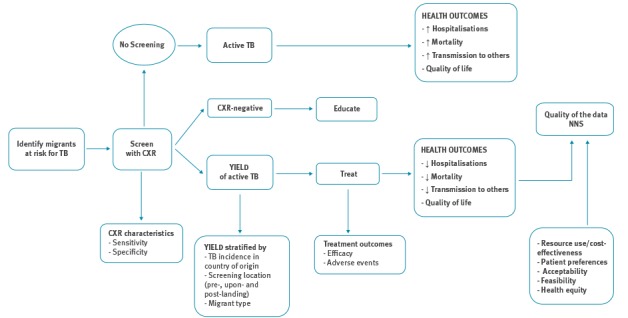
Analytic framework of the evidence chain for active tuberculosis screening in migrants